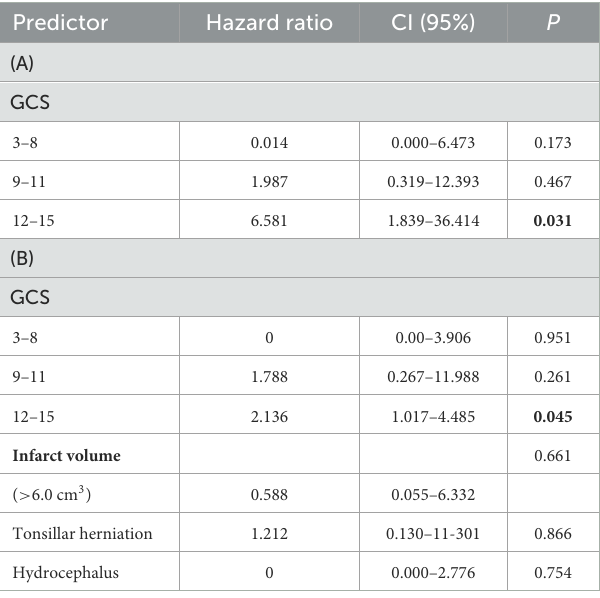
TABLE 3 GCS as a predictor of positive outcomes. TABLE 4 Clinical and radiological predictors of negative clinical